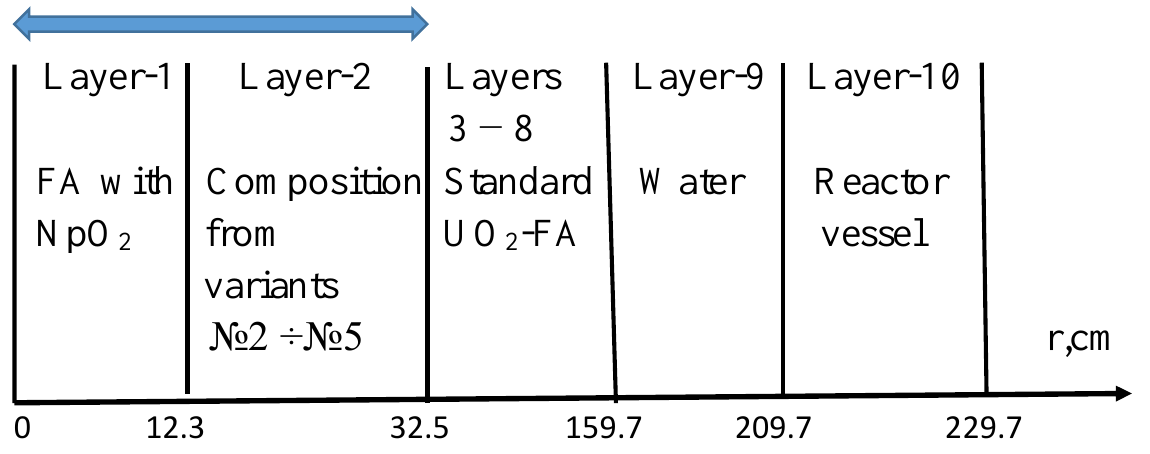
Figure 8. Cylindrical model of the VVER-1000 reactor.